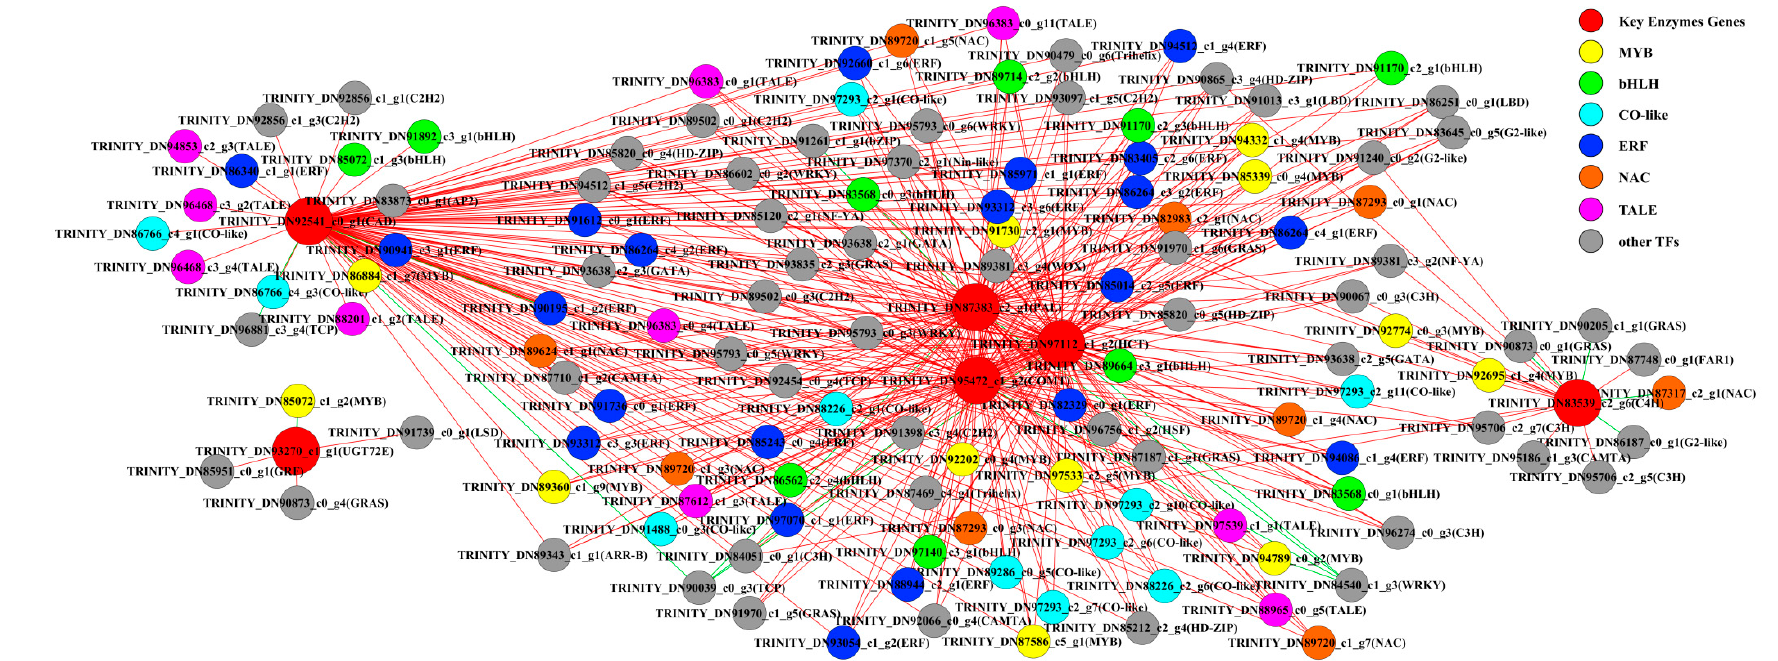
Figure 4. Co-expression analysis of structural genes of phenolic acid biosynthesis pathway and transcription factors (TFs) in the leaves of Cyclocarya paliurus. Red nodes represent genes. Yellow nodes represent MYB TFs. Green nodes represent bHLH TFs. Bright blue nodes represent CO-like TFs. Blue nodes represent ethylene responsive transcription factors (ERF). Pink nodes represent transcription activator-like effector (TALE) TFs. Orange nodes represent NAC (NAM, ATAF, and CUC) TFs. Grey nodes represent the other TFs. Red edges represent positive correlations and green edges represent negative correlations.